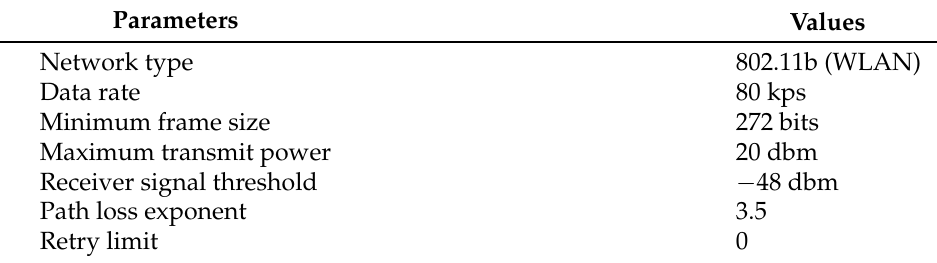
Table 2. Simulation parameters for wireless